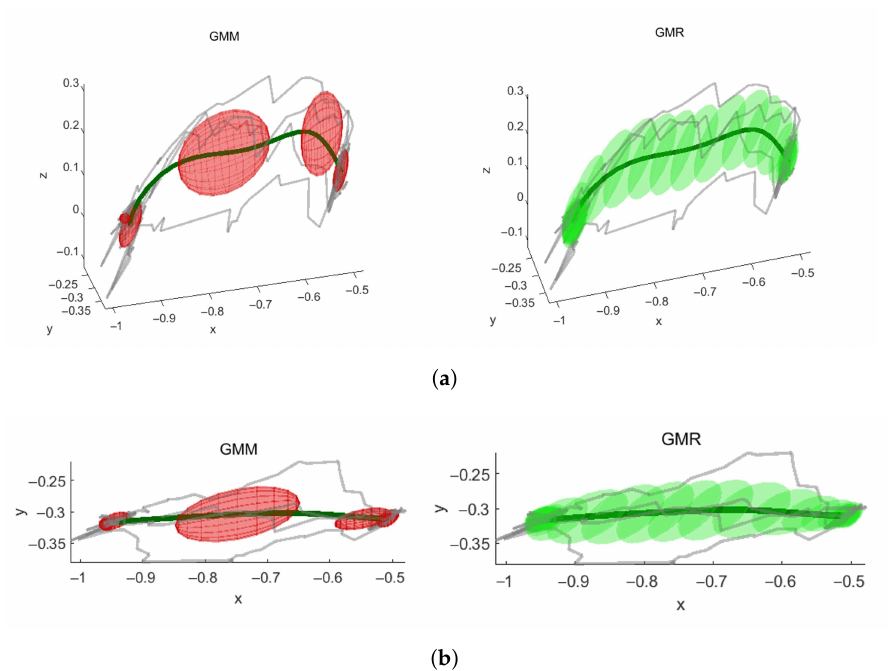
Figure 9. Trajectory learning based on GMR complemented with GMM. ( a ) 3D plot of the GMM and GMR. ( b ) 2D plot of the GMM and GMR. The trajectory of learning is an inverted U-shape, approximately a straight line in the x–y